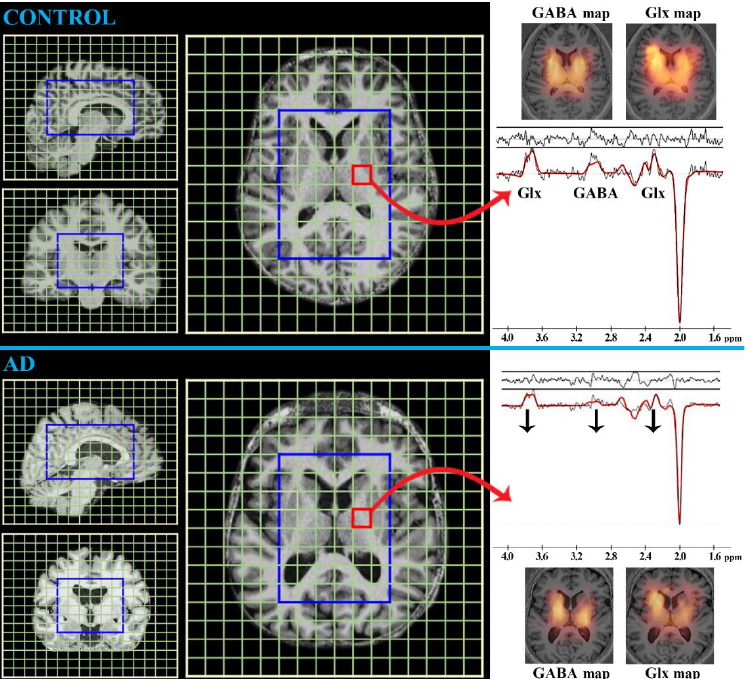
Figure 5. Example of 1 H MRS neuroimaging (T 1 -weighted MRI at 3 Tesla MR-scanner) measured by the multivoxel Mescher–Garwood-editing MRS approach with the represented spectra (one selected voxel indicated with the red square and arrow) showing the main metabolite peaks: glutamate with glutamine (Glx) and γ -aminobutyric acid (GABA). The 1 H MRS spectra for a control subject (35-year-old female) and AD patient (42-year-old female) are depicted with the typical metabolic peak changes being indicated by black arrows ( ↓ : decreased, ↑ : increased). Metabolic maps of the brain tissue are also shown (GABA and Glx maps).